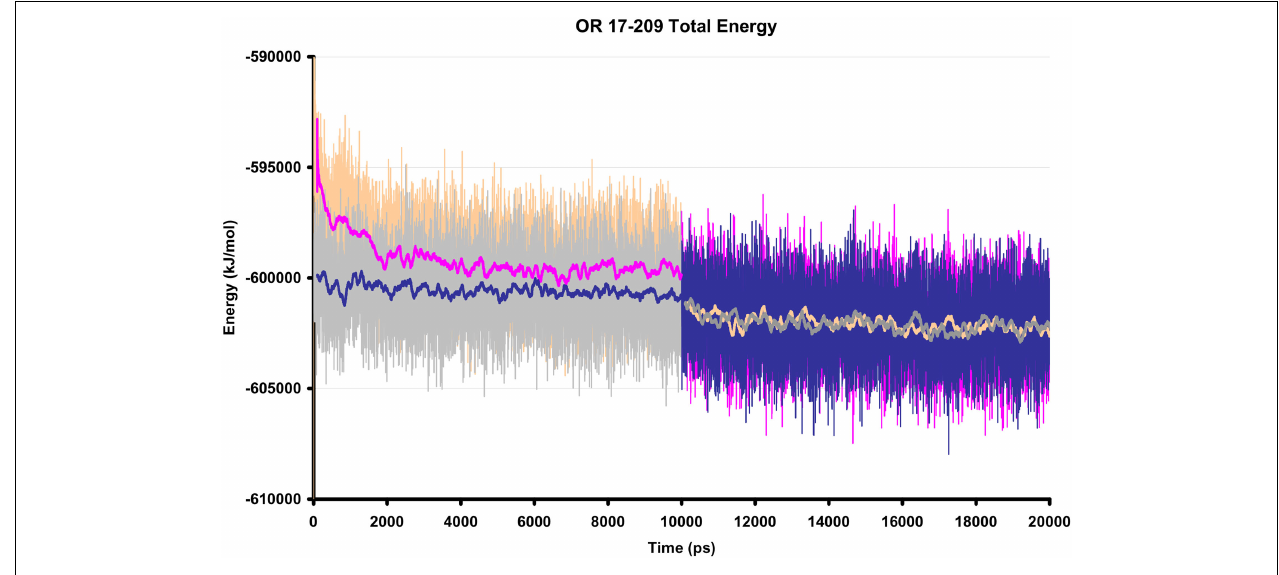
of the unbound system during equilibration (first 10ns) and production MD (final 10ns).The solid lines are 200ps moving averages. During production MD, no significant fluctuations are observed in the energy profiles.